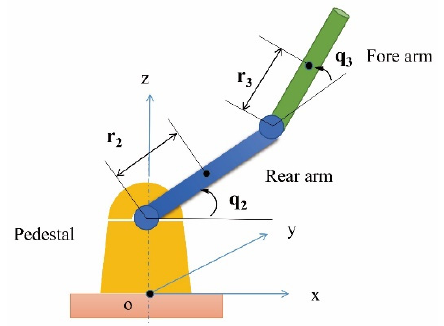
Figure 1. Simplified model of the manipulator. For i = 1, 2, and 3, m i denotes the mass of the connecting rod i , r i denotes the distance from joint i to the center of gravity of the connecting rod i , l i represents the length of the connecting rod i , and q i represents the rotating angle of the connecting rod i